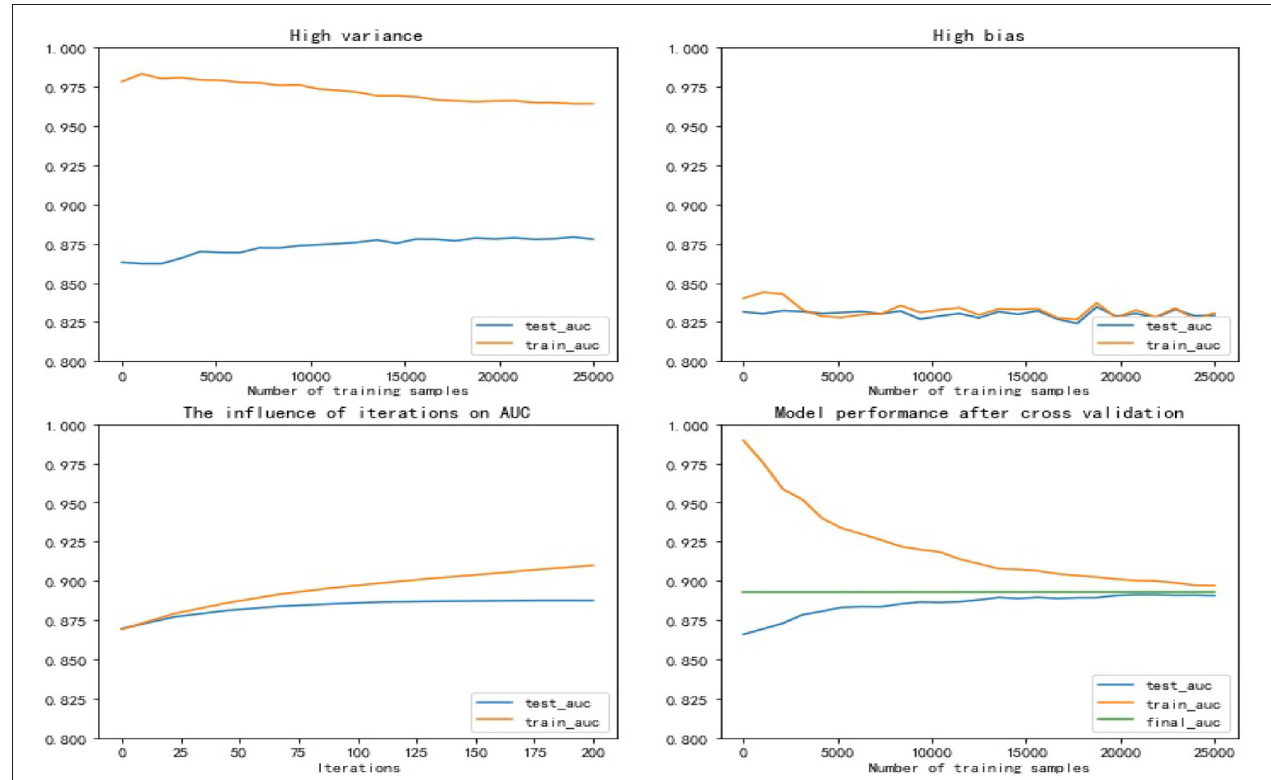
FIGURE 6 | Trade-off between variance and bias.